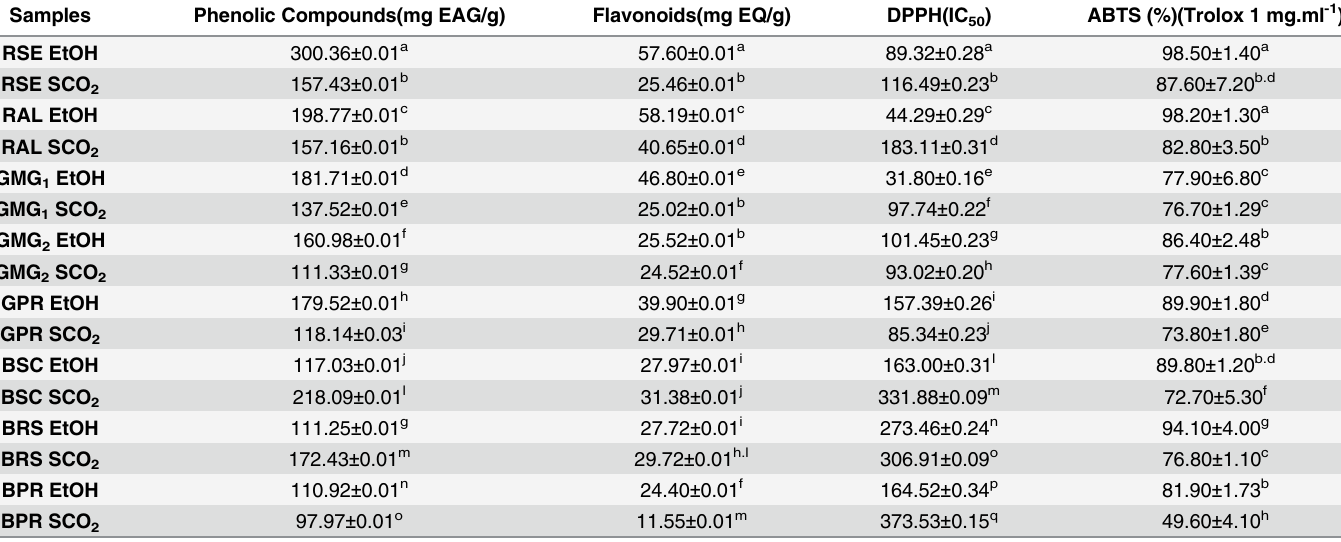
Values showing the same letter on the same column do not show signi fi cant difference (p > 0.05) through the Tukey test at 95% con fi dence level. EtOH – Extracts obtained by ethanolic extraction; SCO 2 – Extracts obtained by SFE (CO 2 as supercritical fl uid); Lower values of IC 50 indicate higher activity of radical elimination.